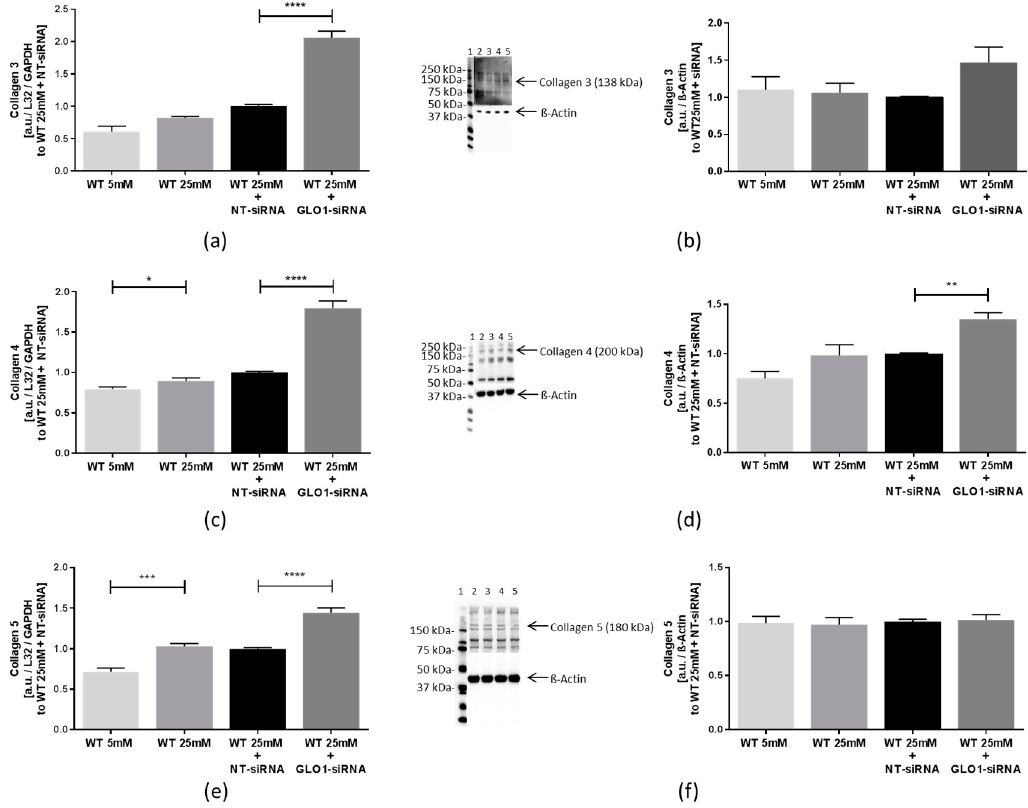
Figure 4. Expression of collagen 3, 4, and 5 in L6 myoblasts transfected with non-target siRNA and